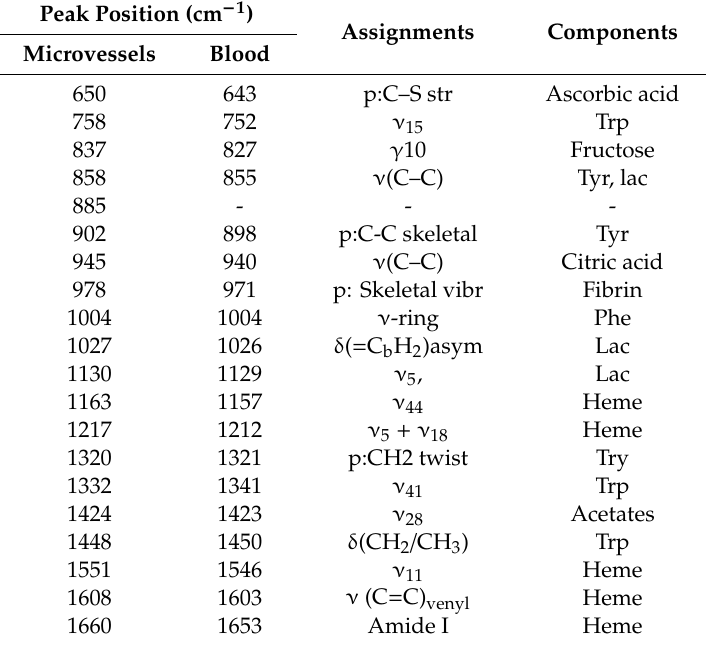
Table 1. Assignments of Raman peaks that are identified in the spectra of the microvessels and blood [45–48].